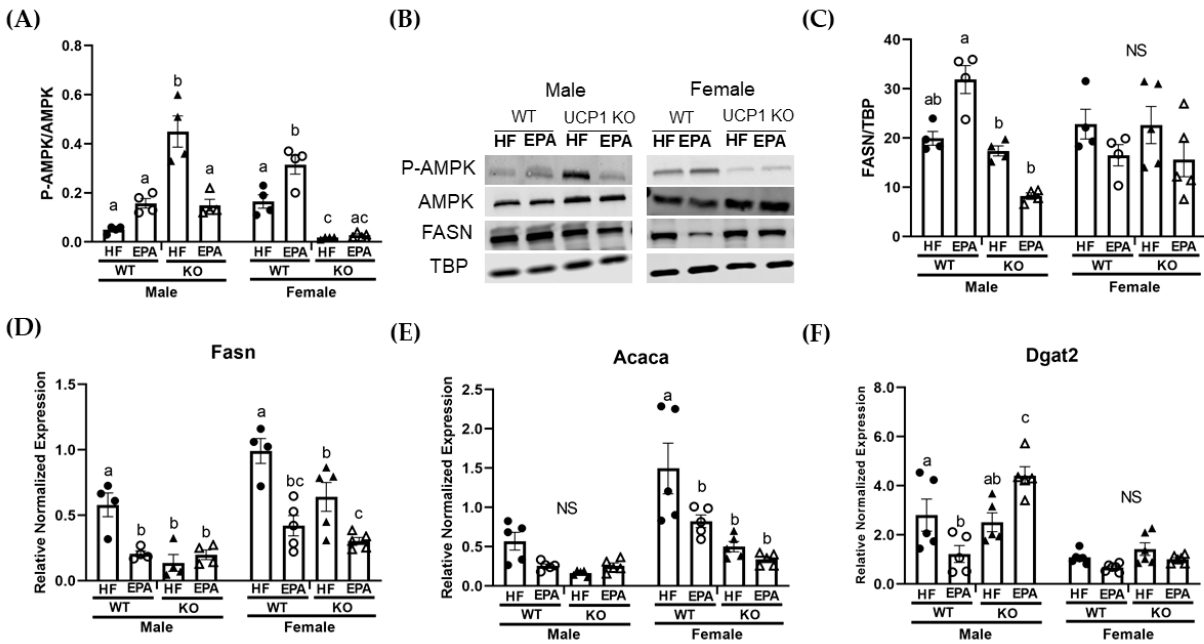
Figure 2. Sex-dependent effects on markers of hepatic lipogenesis. ( A ) Protein quantification of P-AMPK normalized to total-AMPK. In males, P-AMPK was significantly increased in the KO-HF group compared to all other groups, which were comparable. In females, P-AMPK was significantly increased with EPA in the WT groups. Protein levels were comparable between female KO groups. ( B ) Representative western blot images in male and female groups. ( C ) Fatty acid synthase (FASN), normalized to TBP in male and female groups. Gene expression of lipogenic markers in male and female groups, including ( D ) Fasn , ( E ) acetyl-coA carboxylase ( Acaca ), and ( F ) diacylglycerol O-acyltransferase 2 ( Dgat2 ). ( A – F ) Data are expressed as mean ± SEM, n = 4–6; means without a common letter (a, b, c) differ in each male or female group; means with any common letter are not different from each other (a or b vs. ab; b or c vs. bc; or b vs. bc or ab). NS indicates no significant post ‐ hoc comparisons.